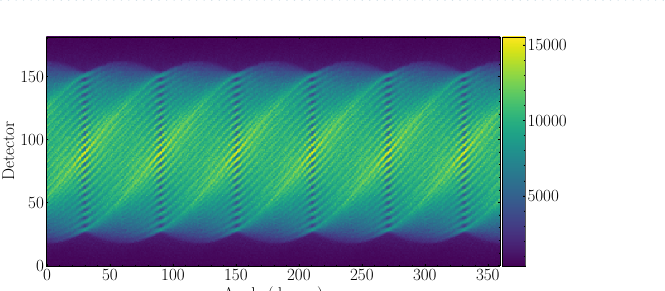
Figure 1. Actual pin distributions in the simulated fuel assemblies (ground truth). Pin activity is proportional to the brightness. In Case 1, the mock-up fuel assembly hosted 331 60 Co pins of 8.879 g/cm 3 density, which emitted 1.17 and 1.33 MeV gamma rays. In Cases 2 and 3, 10% 60 Co pins pins were removed at the center or uniformly. In Cases 4 and 5, 10% 60 Co pins pins were replaced by depleted uranium pins of the same size but higher density (10.4 g/cm 3 ). In Case 6, we decreased the activities of the middle pins by 80% and bottom pins by 50%.